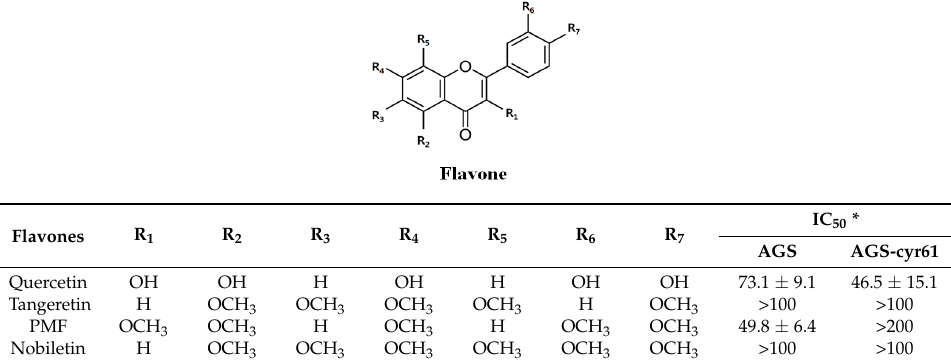
Table 1. Chemical structure and IC 50 value of flavones.